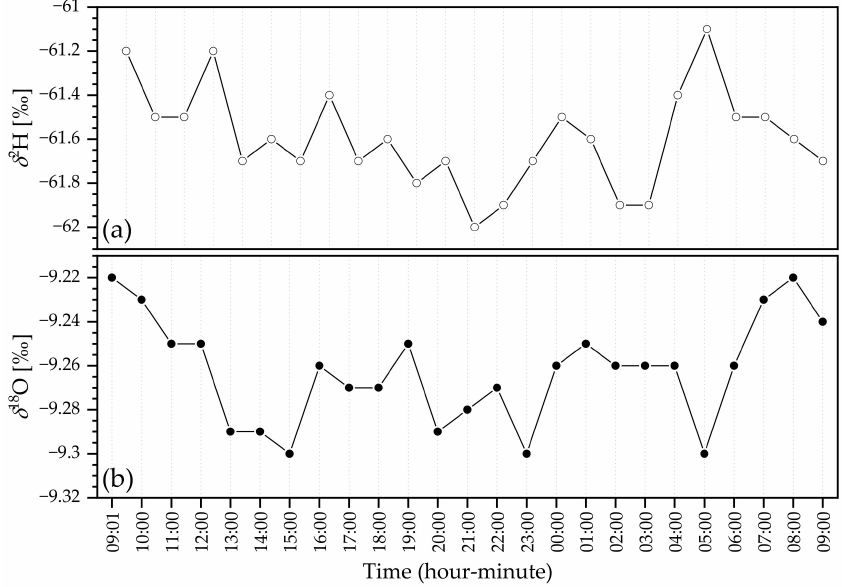
Figure 4. Diurnal variations of stable isotope ratios in tap water: ( a ) δ 2 H, ( b ) δ 18 O. No correlation (r = 0.3) was observed between δ 2 H and δ 18 O since the source